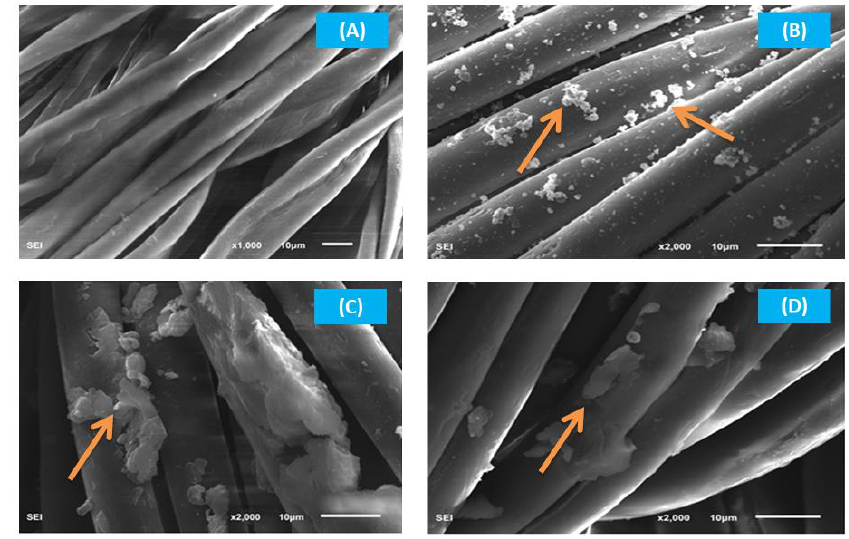
Figure 7. SEM images of: ( A ) RF; ( B ), YCF; ( C ) RCF; and ( D ) BCF.